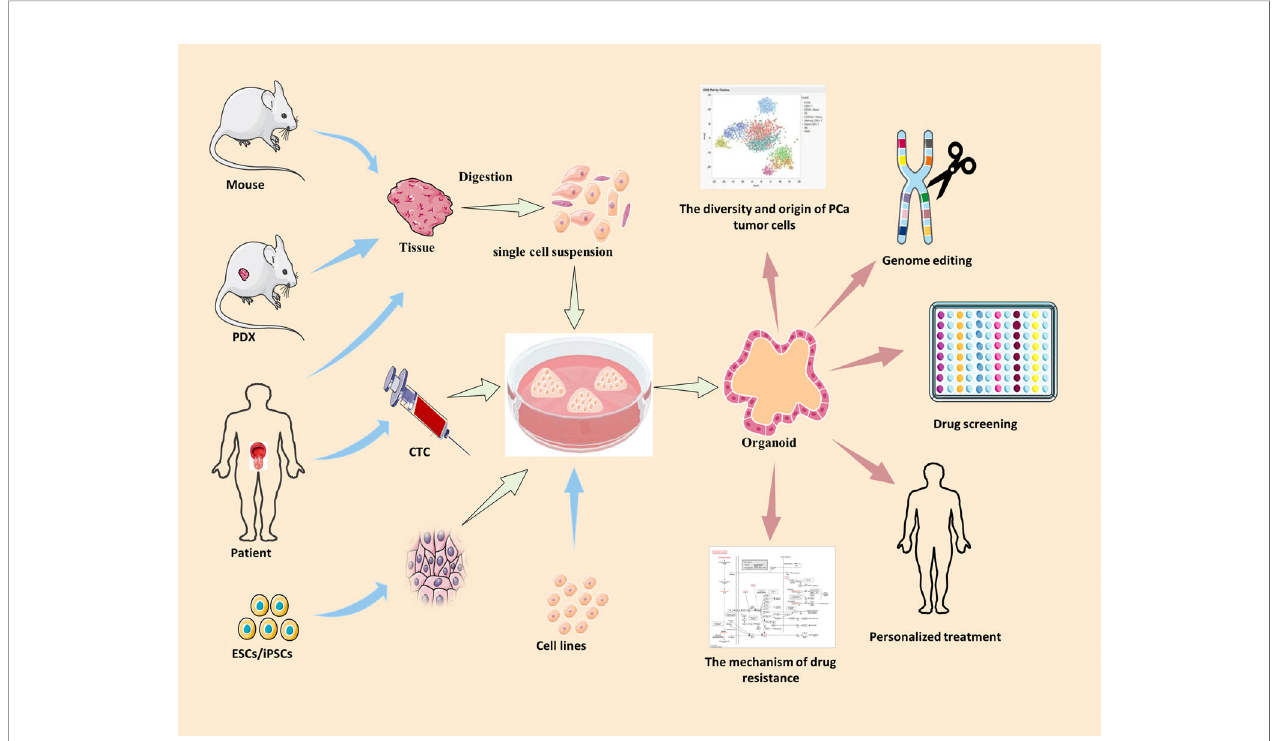
FIGURE 1 | The summary of culture and applications of PCa organoid. Blue arrow ! , the specimen source of PCa organoid. Red arrow ! , the applications of PCa organoid. PDX, patient-derived xenografts; ESCs, human embryonic stem cells; iPSCs, induced pluripotent stem cells; CTC, circulating tumor